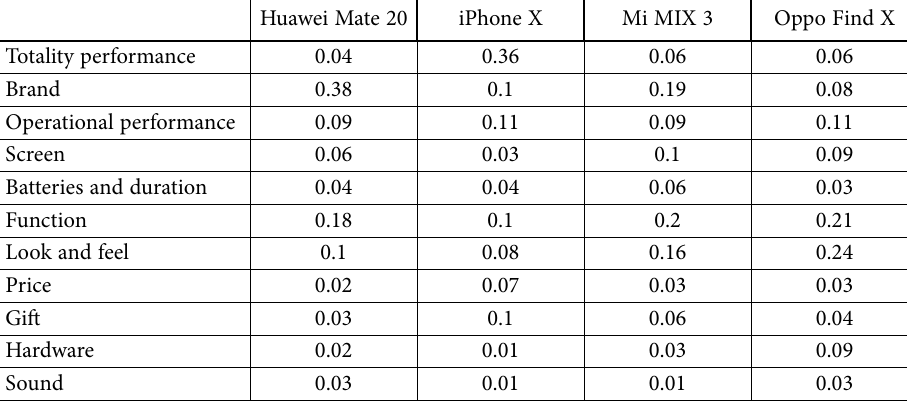
Table 3. Weight matrices of the 11 attributes for four phones on Tmall